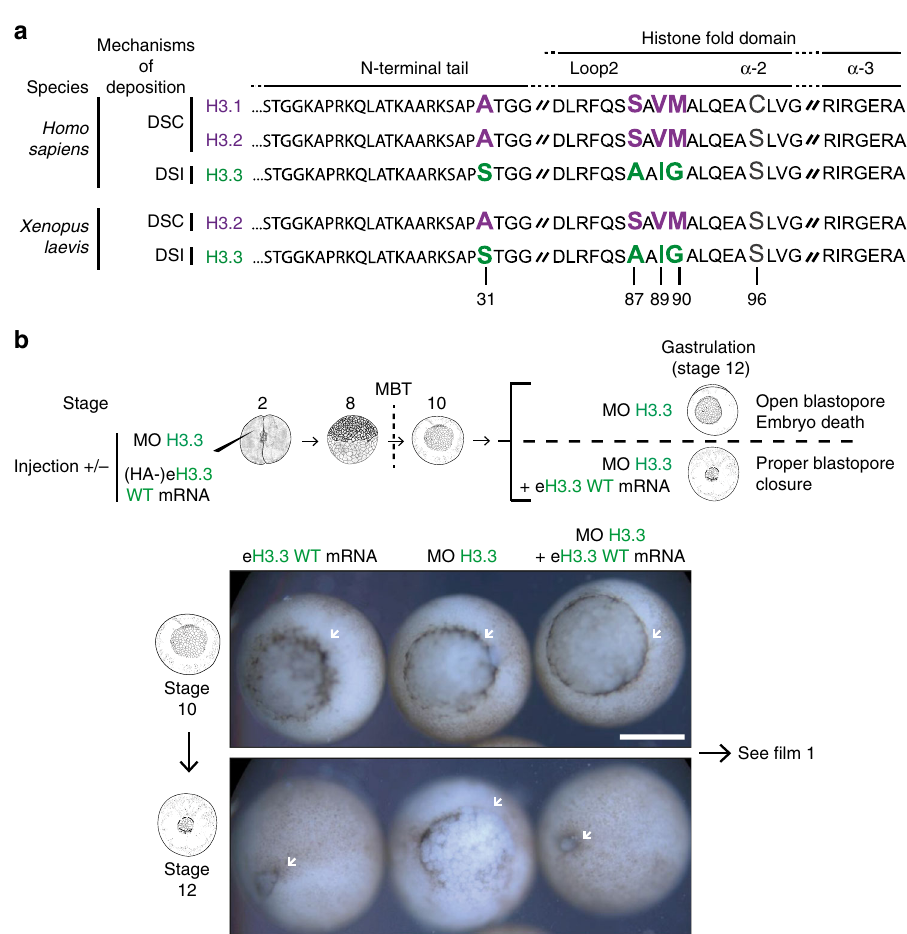
Fig. 1 H3.3 is essential for gastrulation of X. laevis . a Best-studied non-centromeric H3 histone variants in H. sapiens and X. laevis . The two well- characterized forms of non-centromeric H3 variants correspond to the replicative histones H3.1 and H3.2, and the non-replicative histone H3.3, depicted in purple and green, respectively. In humans, the replicative H3 variants differ by only one residue at position 96, a cysteine and a serine, respectively. The non-replicative form H3.3 shares more than 96% identity with the replicative forms, with fi ve and four residue differences with H3.1 and H3.2, respectively. In addition, X. laevis embryos possess only one replicative histone variant, H3.2. Finally, histone sequences are conserved between H. sapiens and X. laevis . DSC: DNA-synthesis coupled, DSI: DNA-synthesis independent. b H3.3 depletion-associated defects and rescue. Morpholino and/or eH3.3 mRNA